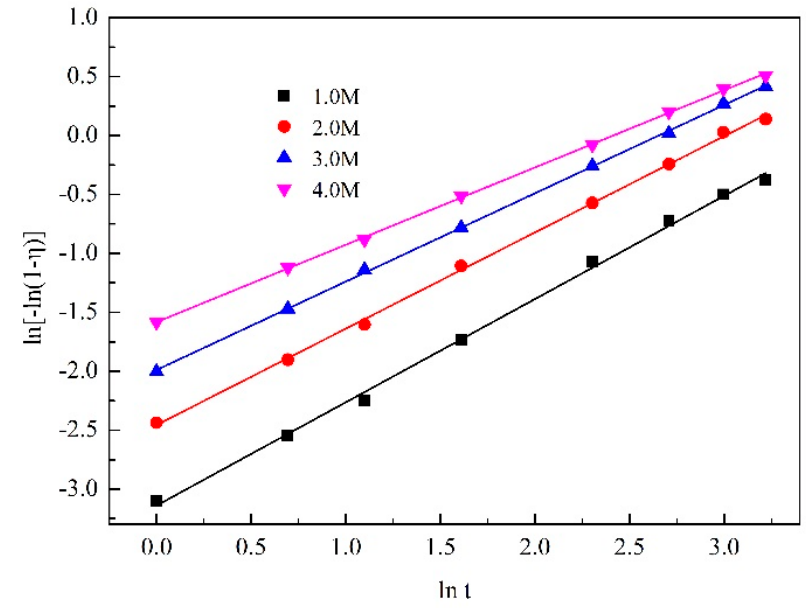
Figure 12. Plots of ln[ − ln(1 − η )] vs. lnt in alkali fused SCC leaching process under different acid concentrations.